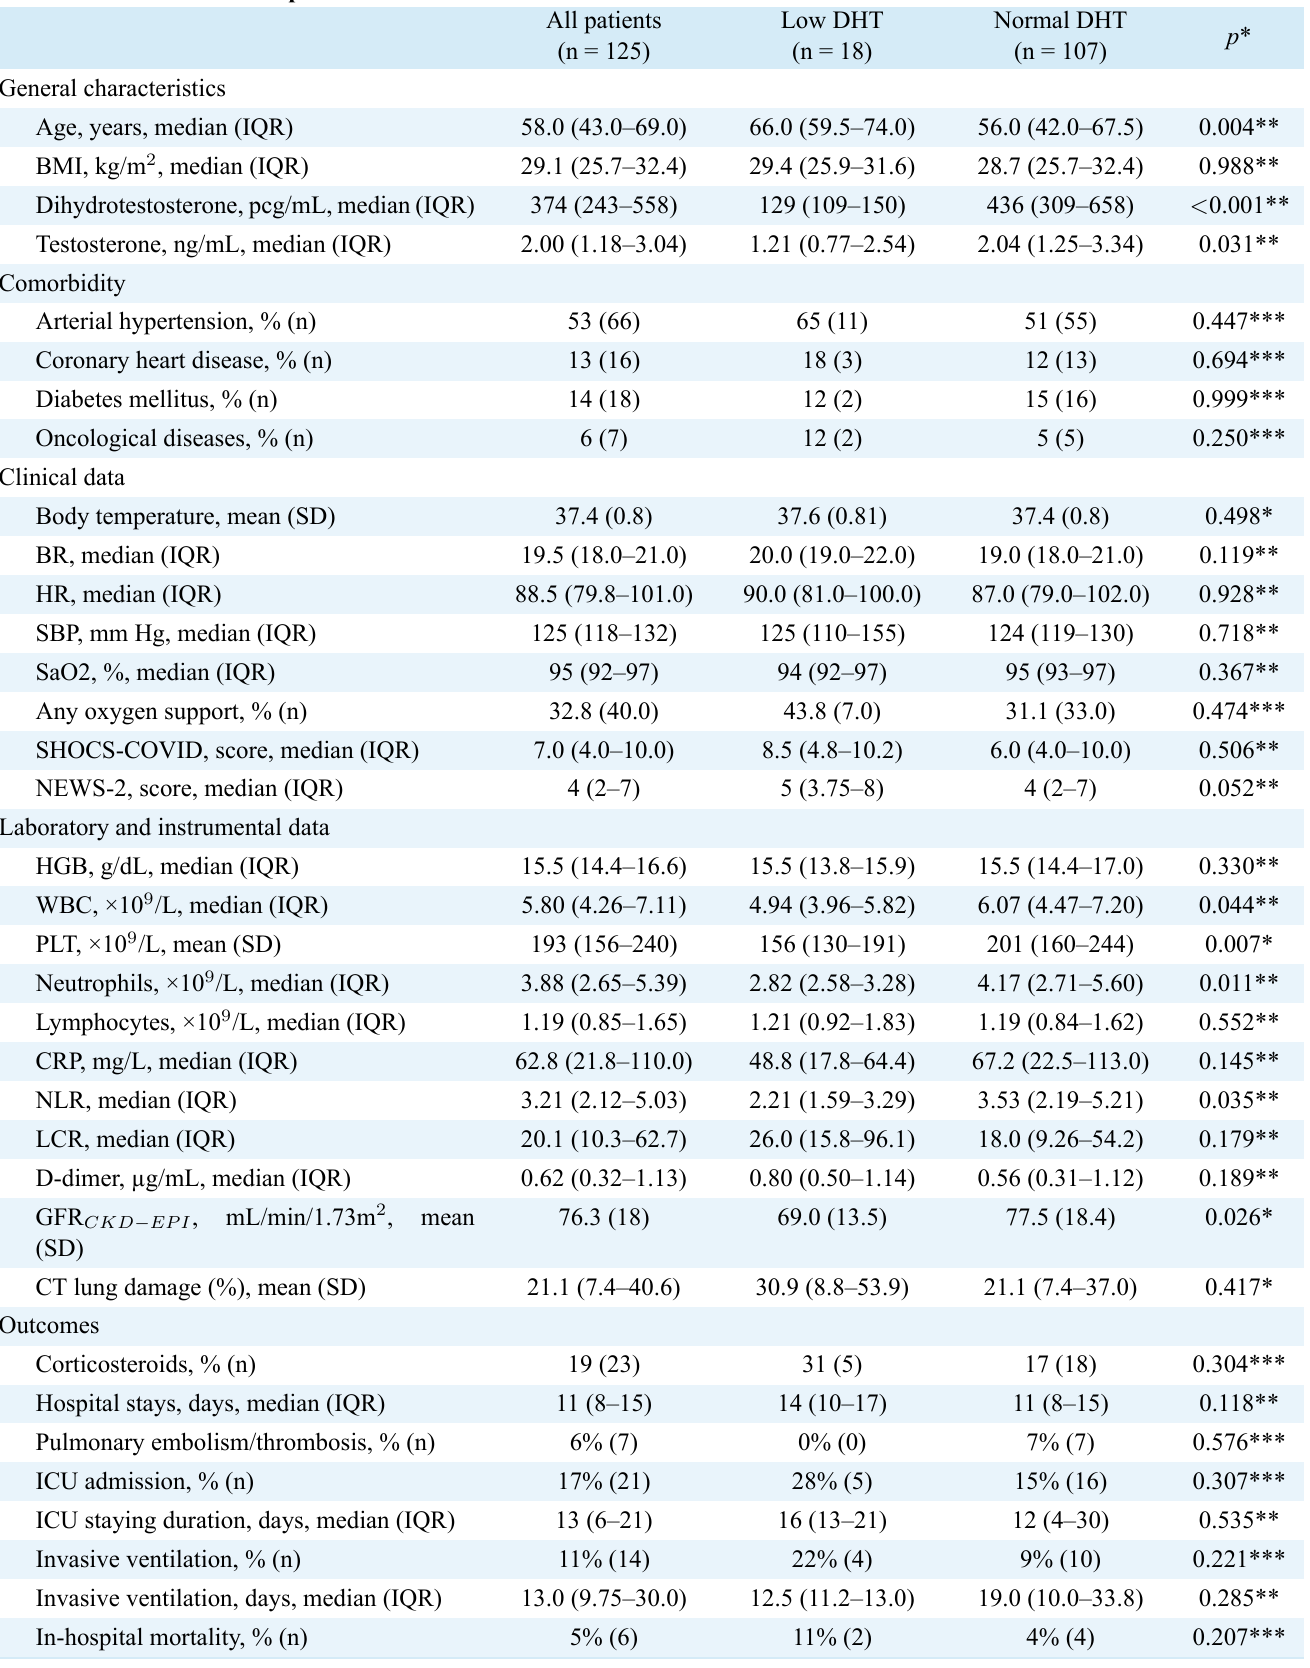
TABLE 1. Comparative characteristics of men with COVID-19 and low and normal DHT levels. All